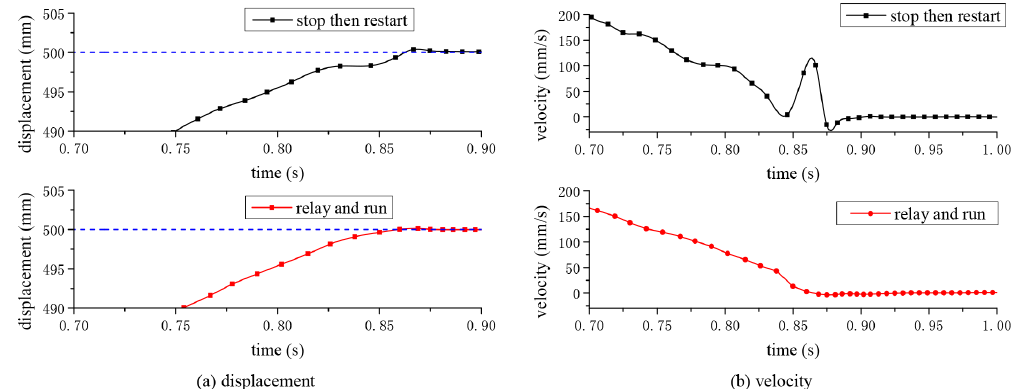
Figure 22. Comparison of the positioning test of 100–500mm with the strategies of relay and run and stop then restart.